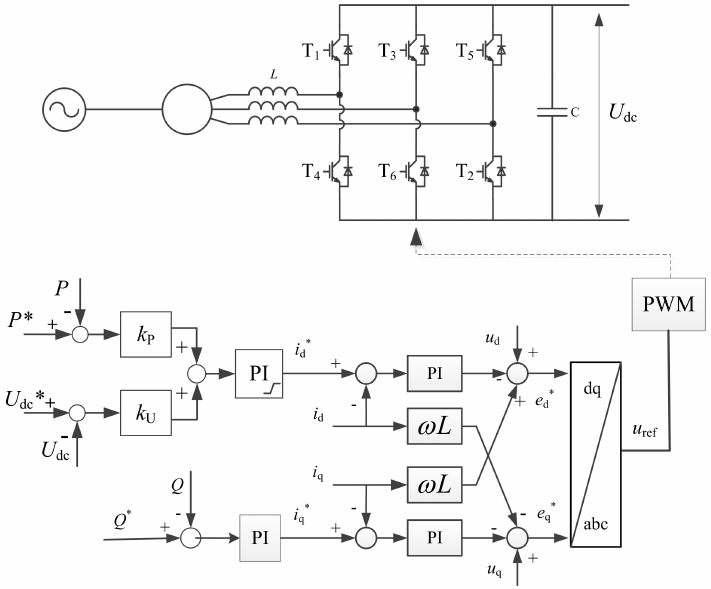
Figure 4. Topology of the two-level DC/AC converter and its droop